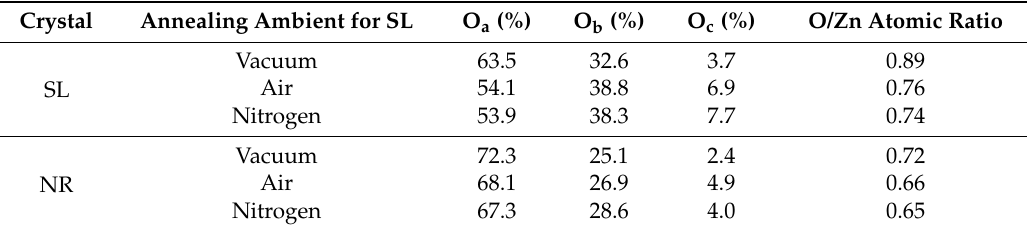
Table 3. Percentage values of each O1s satellite peak for the SLs and NRs calculated by dividing the curve integration of individual satellite peak by the curve integration of total peak. O/Zn atomic ratios extracted from each SL and NR crystal are also shown.